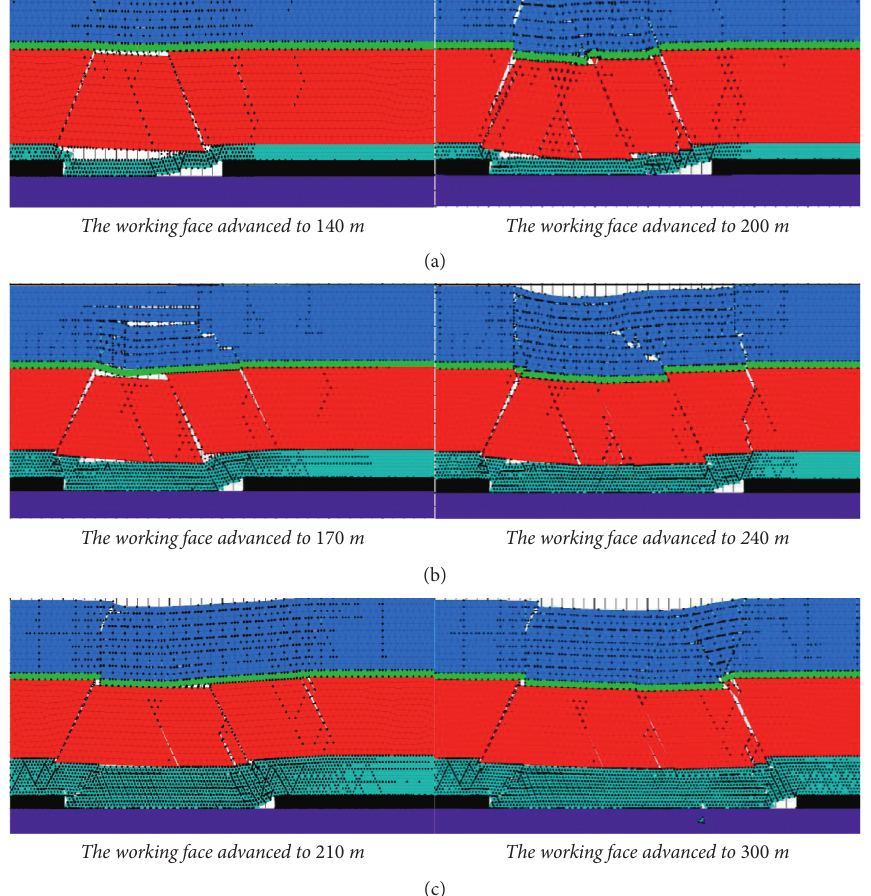
Figure 12: Breakage and migration characteristics of surrounding rocks under different immediate roof filling coefficients. (a) N � 1. (b) N � 2. (c) N � 3.